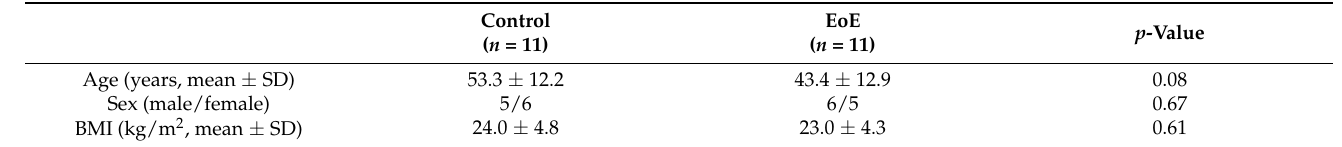
Table 1. Characteristics of controls and EoE patients.